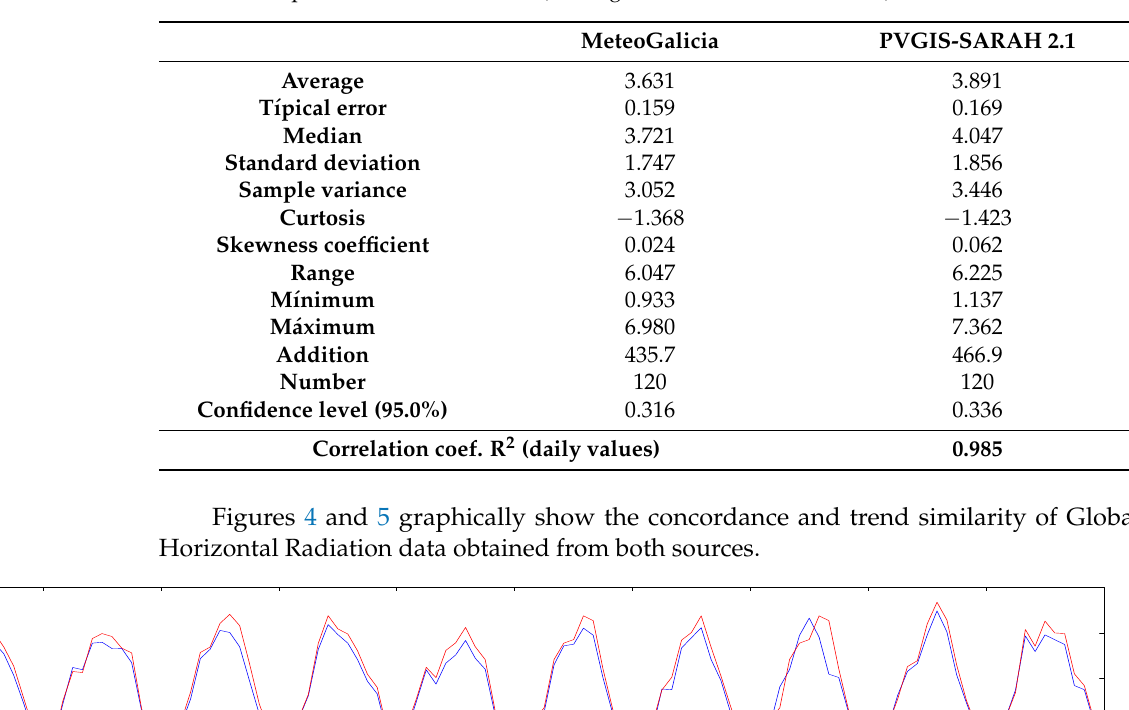
Table 9. Comparative results for GHR (Santiago EOAS station, 2008-2017).